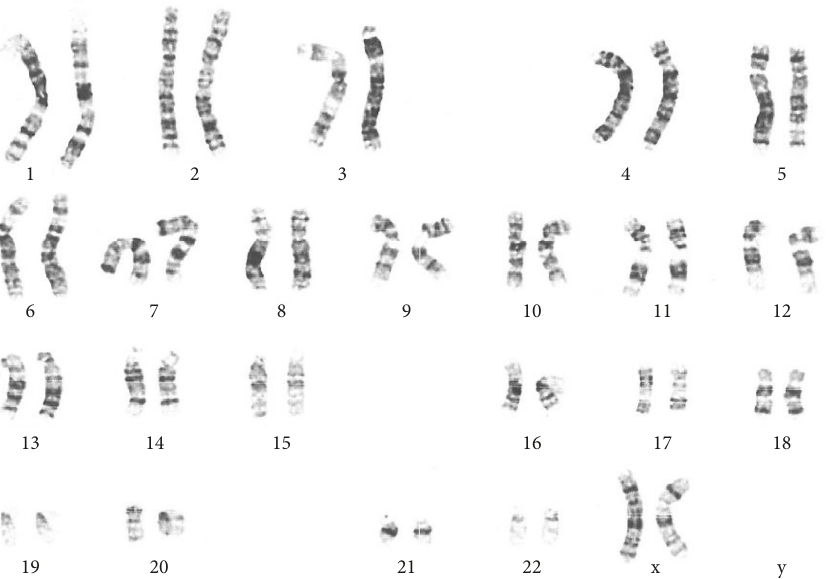
Figure 4: Karyotype of the patient showing 46,XX,r (20)(p13q13.3)/46,XX with mosaicism of